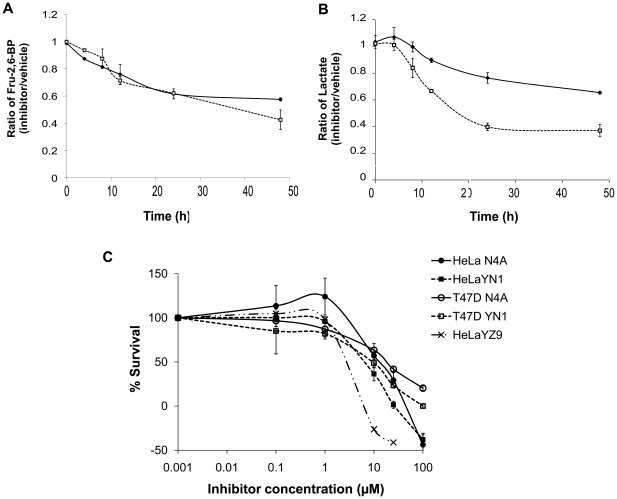
The effects of the PFKFB3 inhibitors on the Fru-2,6-BP levels, the lactate secretions, and the cell growths.The Fru-2,6-BP levels (A) and the levels of secreted lactate (B) were determined enzymatically at time points 0, 4, 8, 12, 24, or 48 hours after the inhibitor treatments of HeLa cells. The results were normalized to the sample protein concentrations and expressed as a ratio to the value of vehicle-treated. Data are means ± S.E.M. from at least three experiments. Time-dependent effects of 25 µM each of N4A (line with diamond) and YN1 (dotted line with hollow square) on the cellular Fru-2,6-BP levels (A) and the lactate secretions (B) are shown. (C) Growth inhibition by N4A , YN1, and YZ9 on HeLa and T47D cells. Cell numbers were assayed over 36 hours by the trypan blue counting or XTT assay. Data points are expressed as % cell growth of control containing vehicle against logarithmic scale of inhibitor concentrations. Error bars stand for intraexperimental replicates standard deviation.